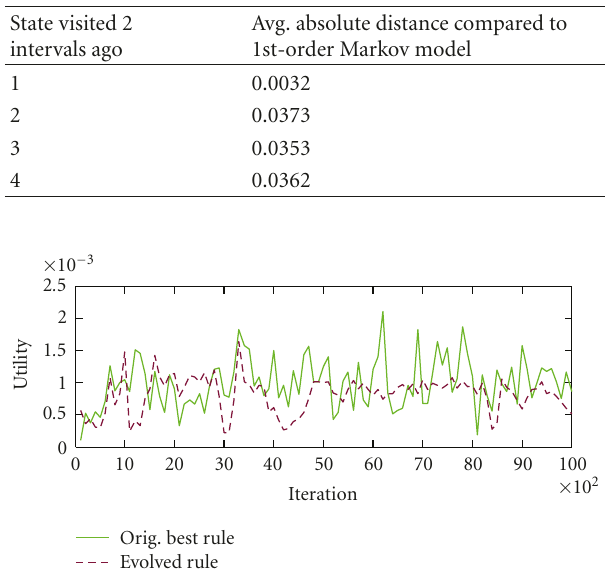
Table 5: Average distance between a first-order and second-order Markov model.